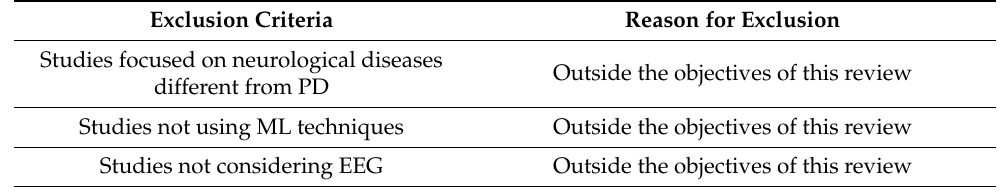
Table 1. Exclusion criteria and reason for the exclusion.